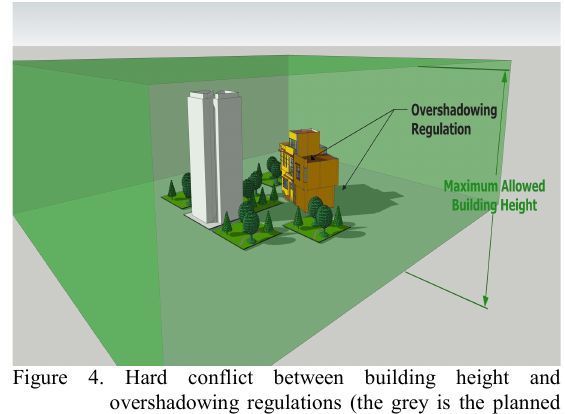
Figure 4. Hard conflict between building height and overshadowing regulations (the grey is the planned building (left) and the other is the existing building (right))